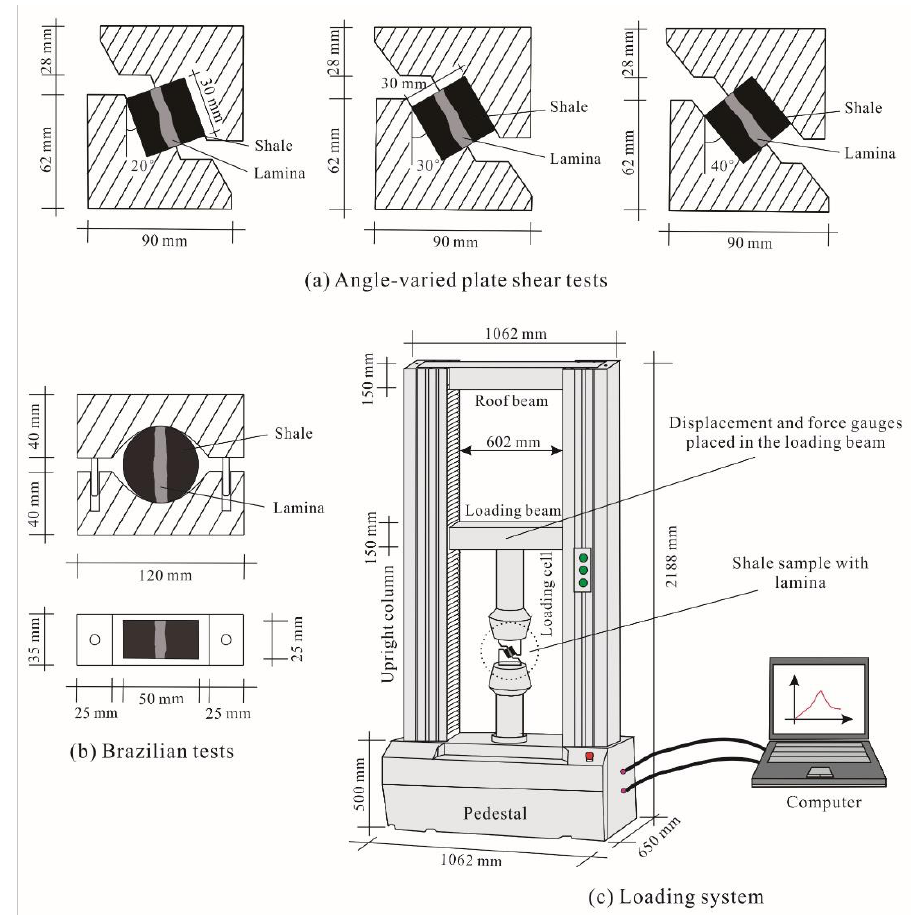
Figure 4. Apparatus used for mechanical tests. ( a ) Shale samples with laminae for angle-varied plate shear tests. ( b ) Shale samples with laminae for Brazilian tests. ( c ) Loading system of microcomputer-controlled electronic universal testing machine MTS-SANS CMT.